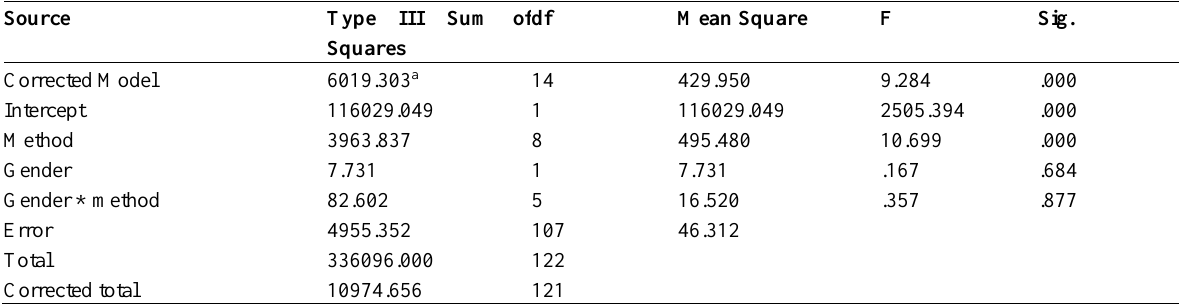
The data presented in Table 1 shows F-calculated values for three effects: treatment, gender and interaction effect of treatments and